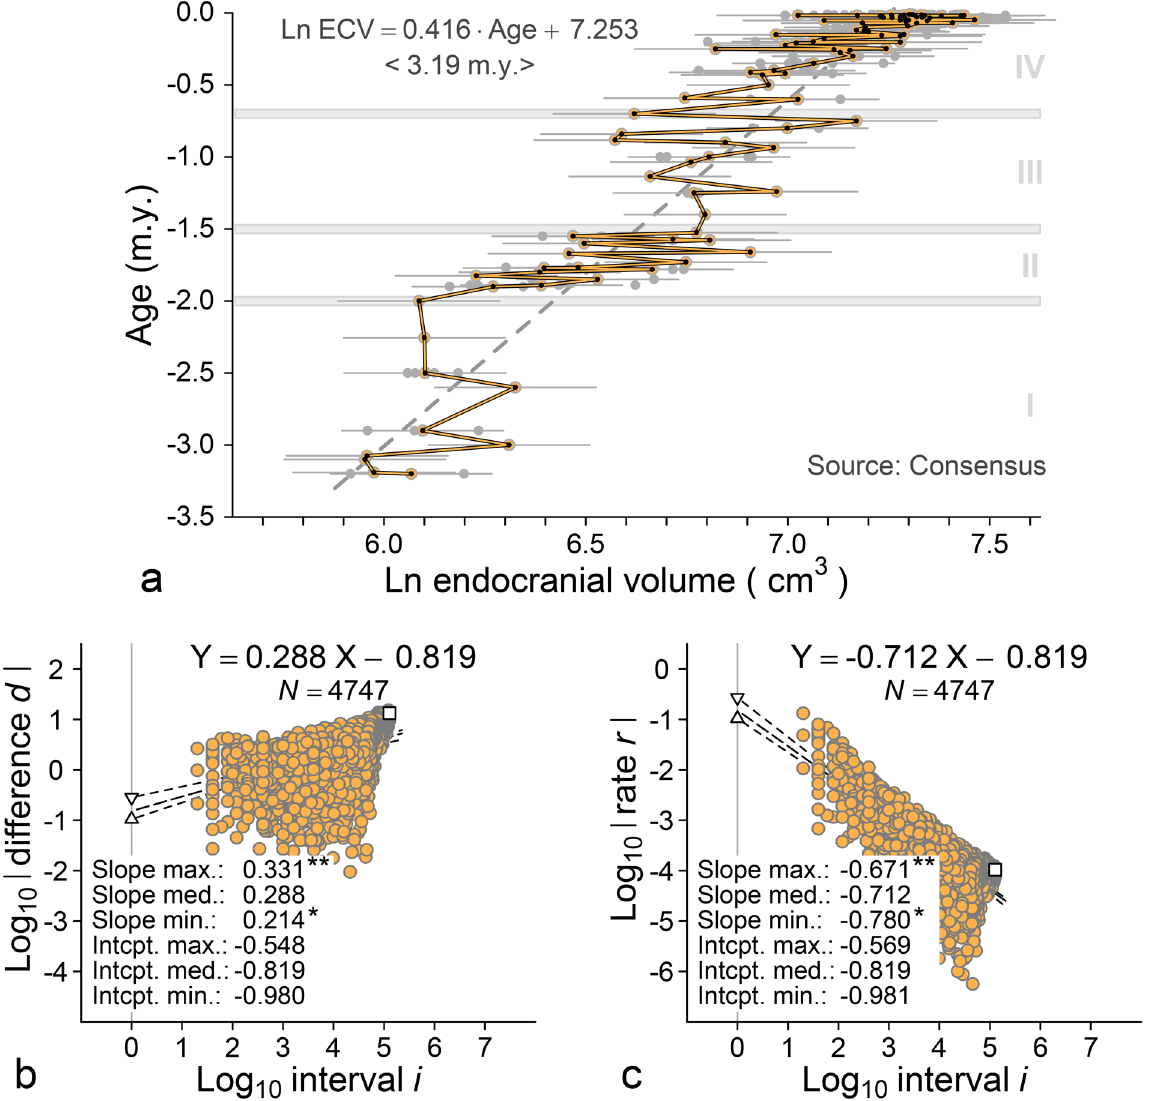
Figure 1. Brain size evolution in the broad lineage of Plio-Pleistocene hominins leading to modern humans. ( a ) Consensus pattern of change in endocranial volume for 233 hominin specimens representing 98 geological ages (Supplementary Dataset 1). Solid yellow line traces mean ECV values through successive ages. Regression of ln endocranial volume on geological age (dashed line) yields a single long term rate of 0.416 ln units per million years (ca. 1.041 × 10 −4 standard deviations per generation) on a time scale of 3.19 m.y. (127,600 generations). Four phases of stasis and change, I–IV identified in Fig. 3, are shown in the background. ( b ) Log-difference- interval or LDI temporal scaling plot of change per unit time for all pairwise combinations of differences (in standard deviation units) and associated intervals (in generations) separating samples in the 98-age time series. ( c ) Log-rate-interval or LRI temporal scaling plot of change per unit time for all pairwise combinations of rates (in standard deviations per generation) and associated intervals (in generations) separating samples in the 98-age time series. Note that LDI and LRI slopes of 0.288 and − 0.712 differ by one unit: each indicates a time series more stationary than expected for purely random change. LDI and LRI intercepts are equal and indicate a step rate of 10 −0.819 = 0.152 standard deviations per generation on a time scale of one generation. The long-term difference and the long-term rate of change represented by the dashed line in panel a are plotted as open squares in panels b and c